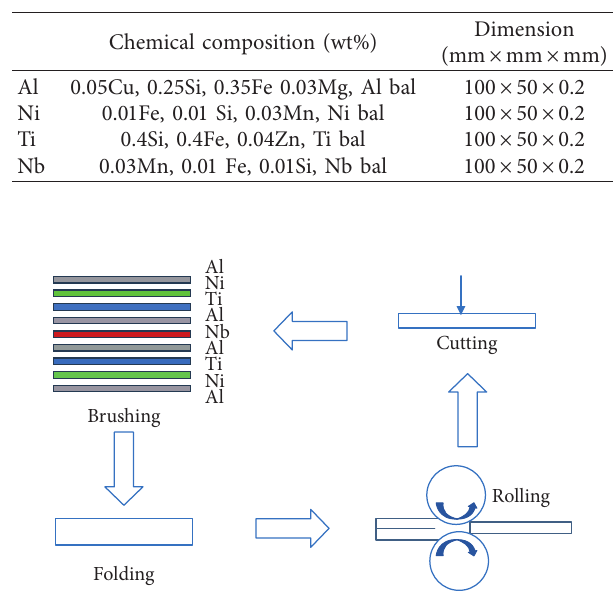
Figure 1: Schematic illustration of the accumulative roll bonding